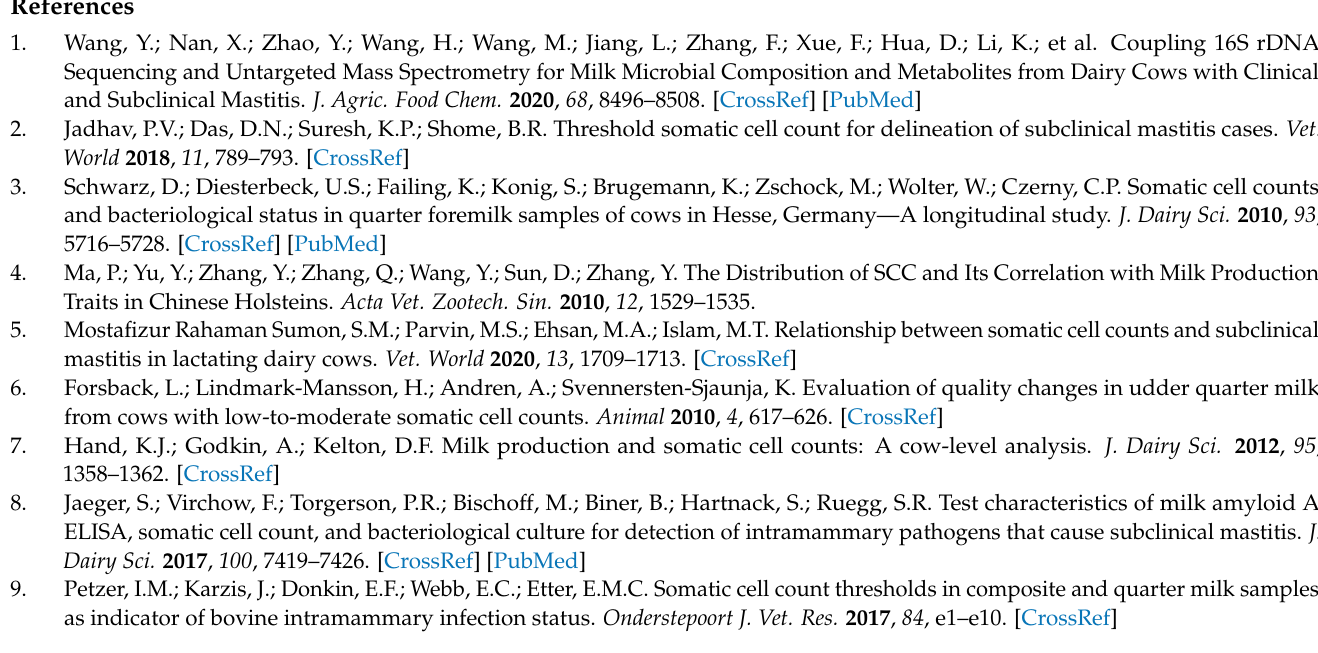
Figure S2: Closeness centrality of differentially abundant genera shared in two sites; Figure S3: Linear regression analysis of expression levels of shared DEGs with the same regulation direction in two sites; Table S1: 16S rRNA gene V3-V4 amplification PCR reactants; Table S2: Pairwise comparison of alpha diversity after correcting